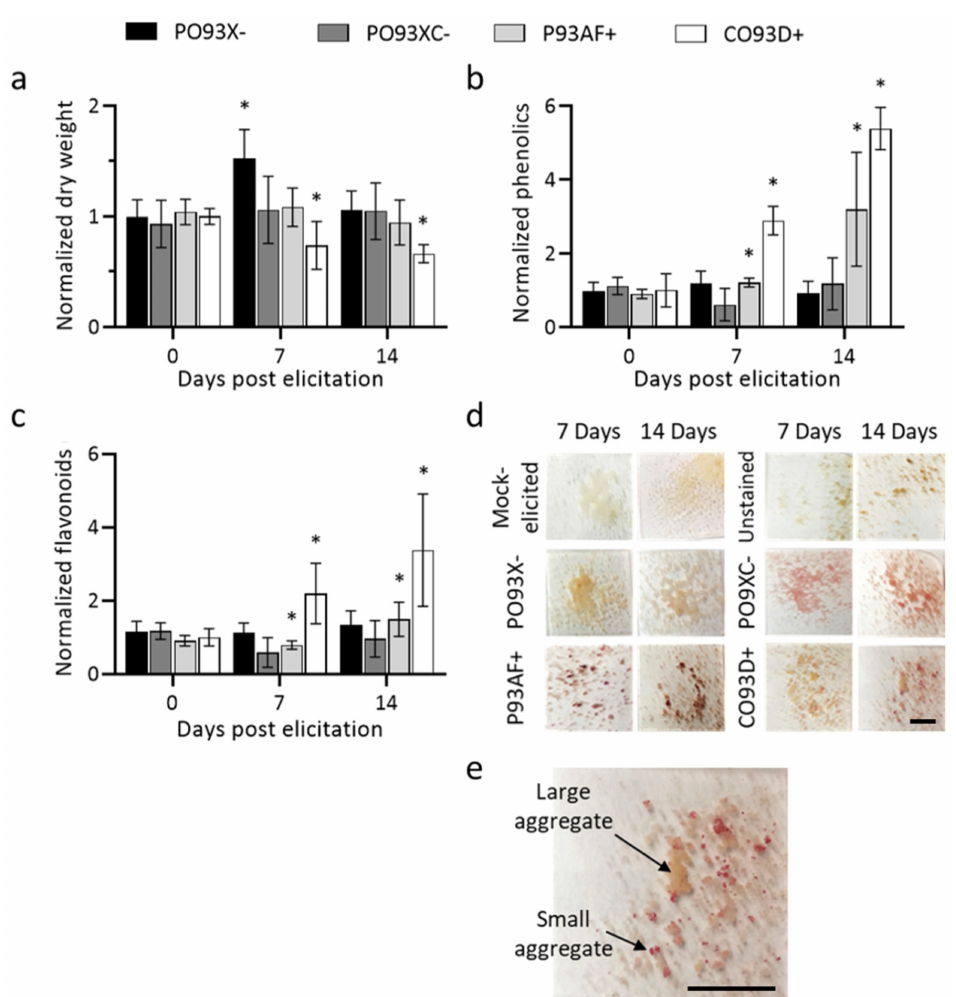
Figure 2. Effect of methyl jasmonate on paclitaxel and non-paclitaxel accumulating Taxus cultures. Dry weight ( a ), phenolic content ( b ), and flavonoid content ( c ) were quantified in PO93X − , PO93XC − , P93AF+, and CO93D+. These data were normalized to mock elicited controls. Lignin was stained using the phloroglucinol assay creating a red pigment in aggregates where lignin is present (scale bar is 5 mm) ( d ). Differential lignin accumulation from the CO93D+ culture in a magnified representative image (scale bar is 5 mm) ( e ). ( n = 3 biological replicates, error bars = standard deviation) (Student’s t -test compared to 1, * p <